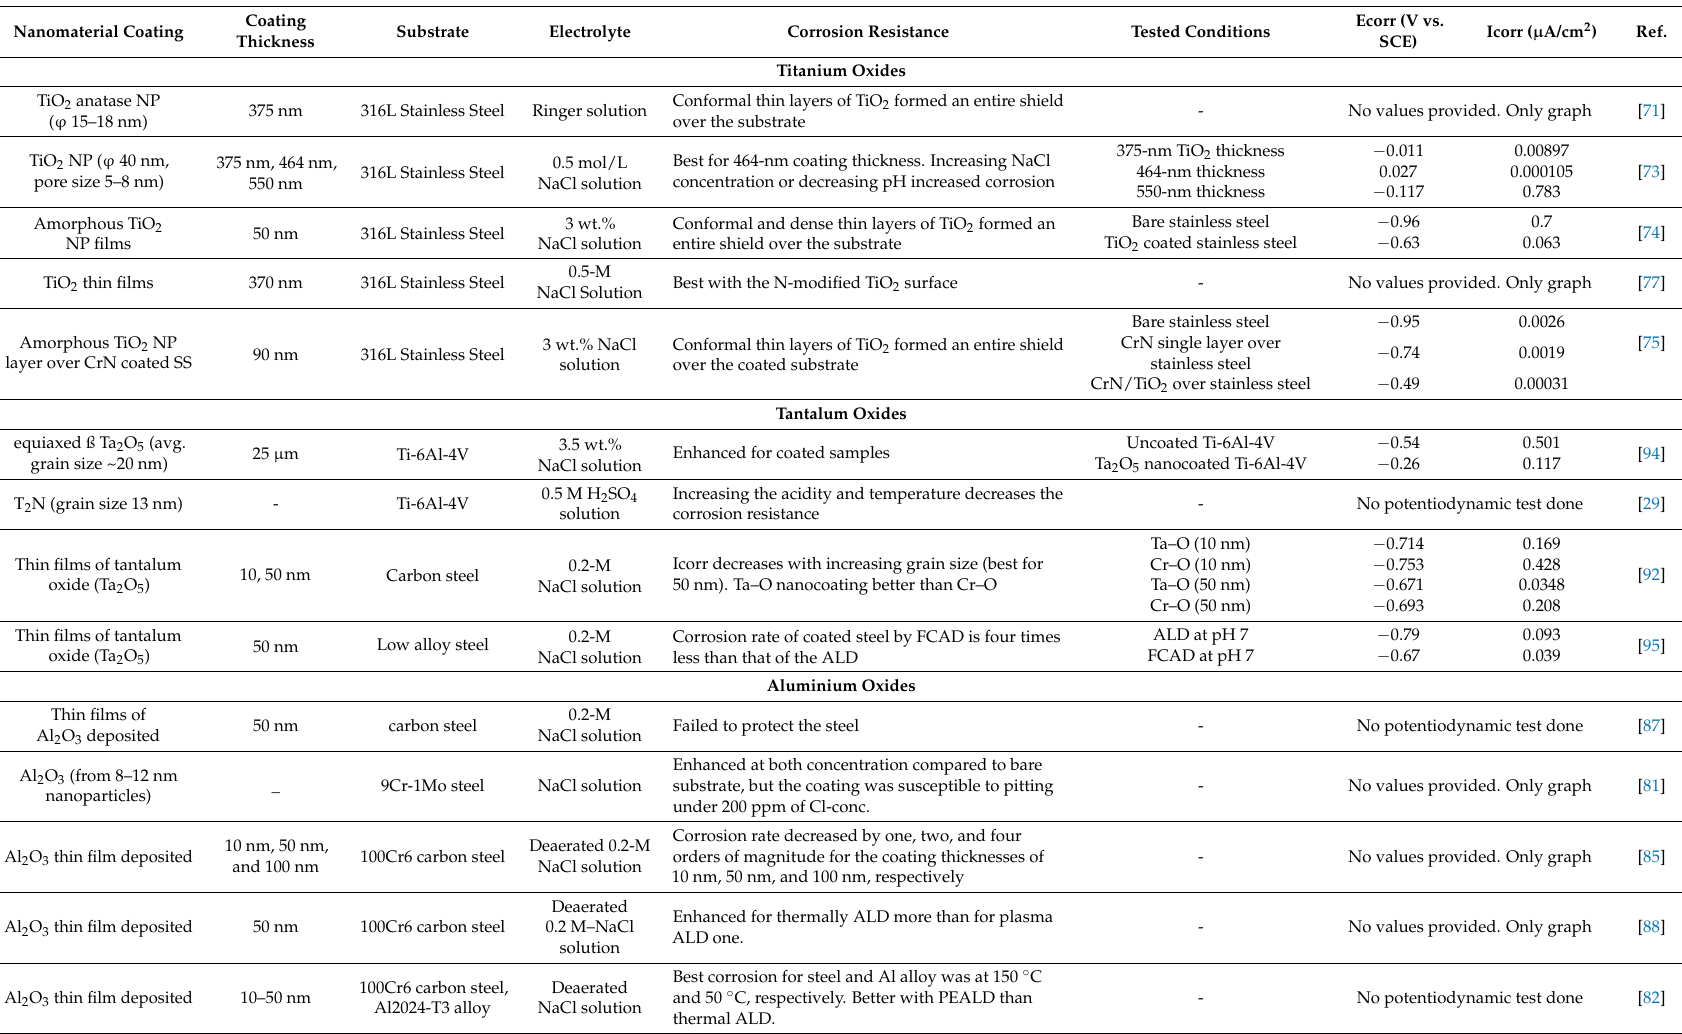
Table 2. Summary of some corrosion parameters of ceramic